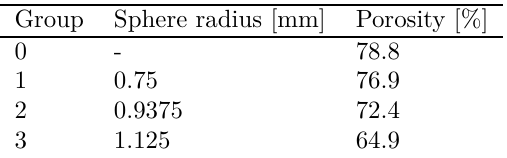
Table 2. Design parameters - joint reinforcement variations.